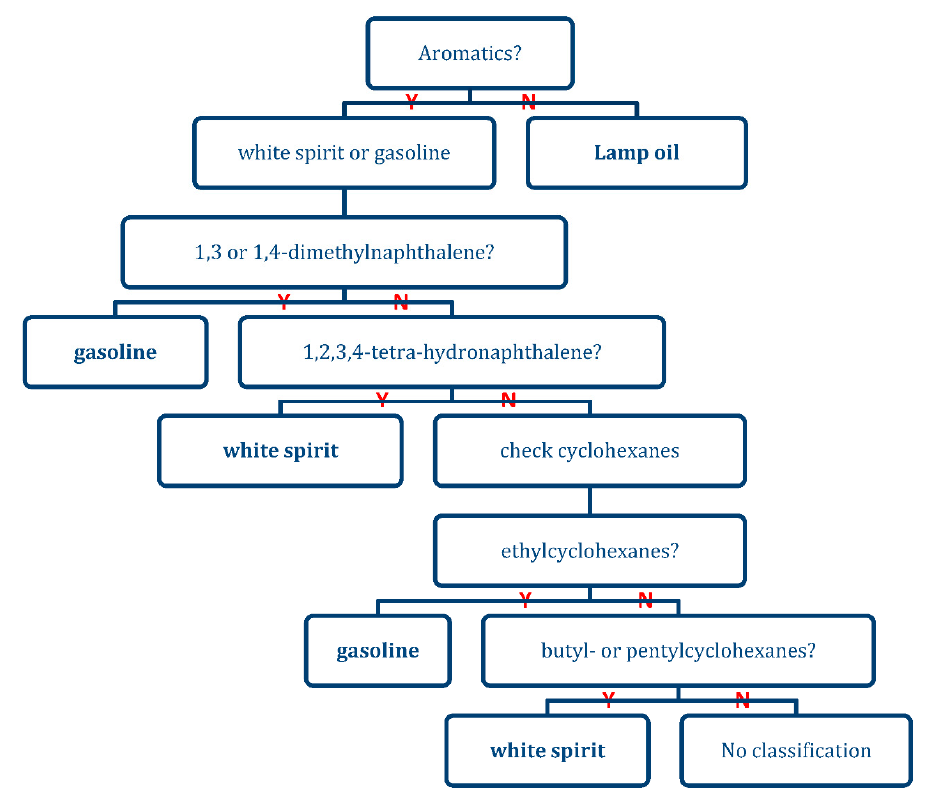
Figure 9. A heuristic model created from Table 6.